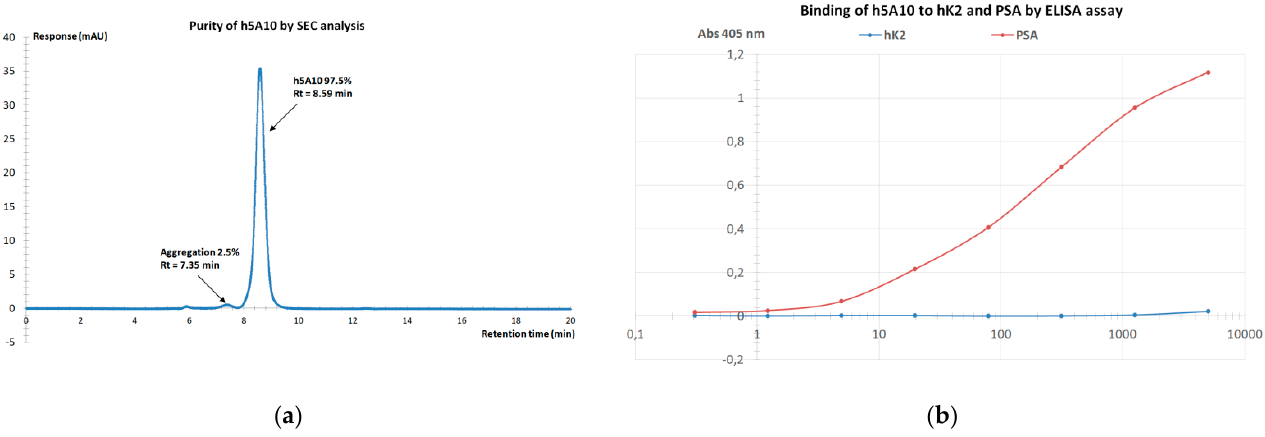
Figure 1. Sequence alignment of humanized 5A10, parental murine antibody m5A10, and the template sequences used for humanization. (Panel A ) shows the sequences of the heavy and (Panel B ) those of the light chain variable domains. In the case of the heavy chain, the template sequences comprise the consensus sequence of V H 2-family and IGHJ4-gene encoded segment and in the case of the light chain, the consensus sequence of V k 1-family and IGKJ1-gene encoded segment, respectively. The positions where m5A10 and the template sequences differ are bolded in h5A10. The framework (FR) and the complementarity determining regions (CDRs) of the variable domains are indicated. CDR definitions and numbering are according to [10]. The characters with small letters in the consensus sequences stand for: s = “small residue” (A,C,D,G,N,P,S,T,V) and a = “aromatic residue” (F,H,W,Y).